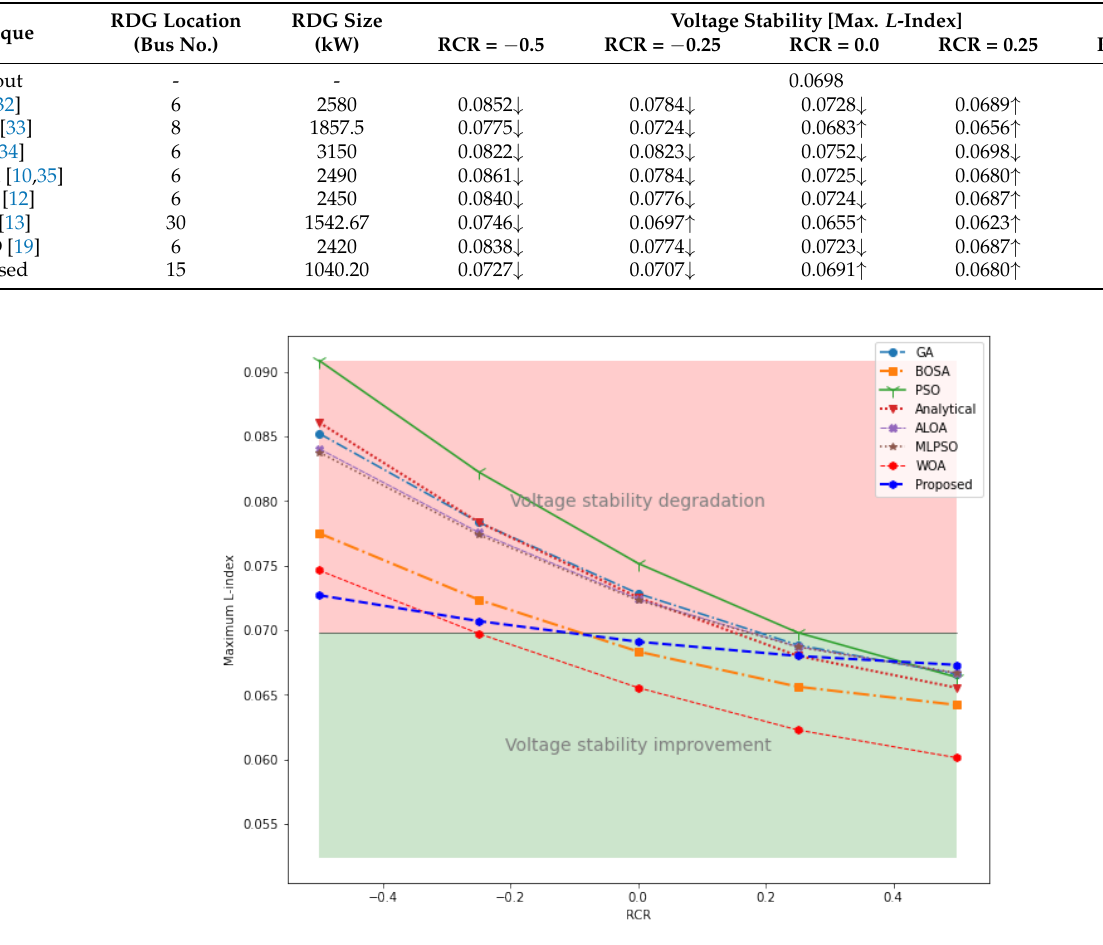
Figure 10. Variation of voltage stability with reactive compensations of 1 RDG using maximum L -index.